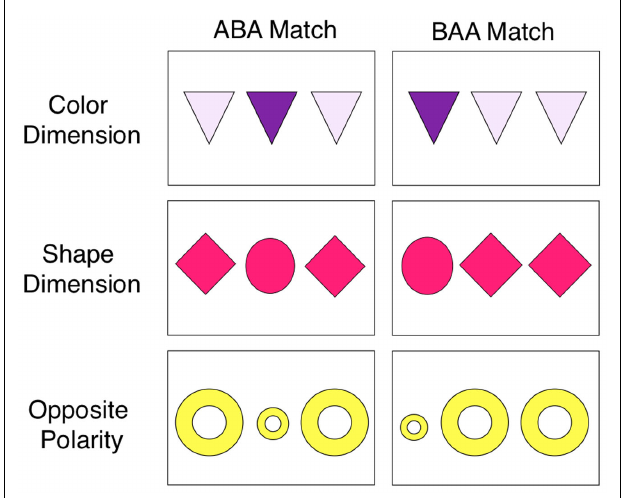
FIGURE 2 |Test trials from Experiments 1 and 2.